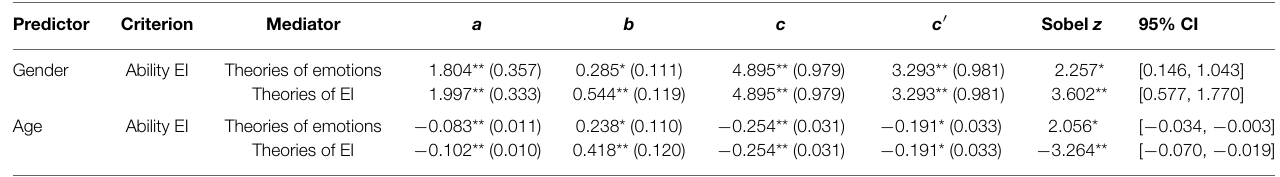
TABLE 3 | Implicit theories of emotions or EI as mediators of the relationship of gender or age with total ability EI. Predictor